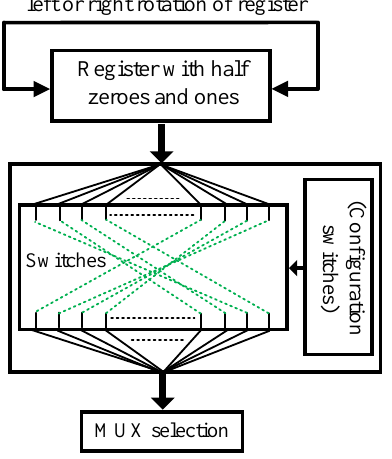
Figure 14. Generating a random key using the rotate right or left operation with dynamic